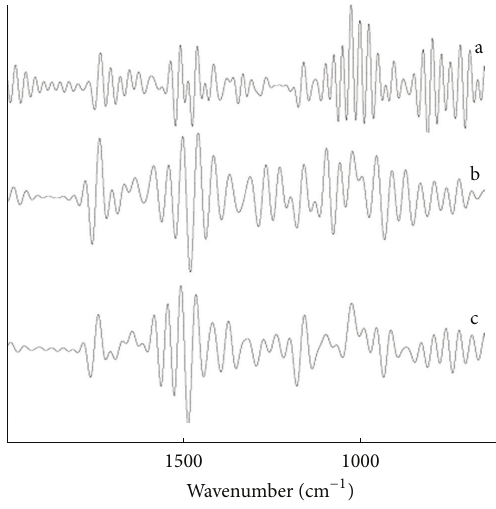
Figure 2: FSD-IR spectra of the Radix Bupleuri and its unofficial varieties. a. Radix Bupleuri ; b. root of the Bupleurum smithii Wolff; c. root of the Bupleurum bicaule